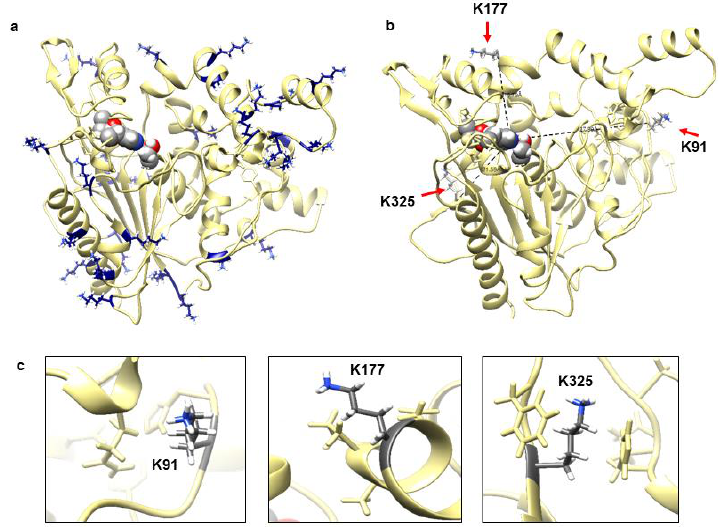
Figure 1. ( a ) Predicted model structure of WT lipase with catalytic triad in sphere shape located at the protein centre core. All lysine residues were distributed all over the protein surface were shown in heteroatoms colour. ( b ) The distance of three lysine residues (shown by red arrow) from catalytic triad (sphere shape heteroatom colour). ( c ) The location of three selected lysine (K91, K177, and K325) at coil, helix, and beta are shown in element colour with neighbouring residues. The figure was generated by Chimera v1.13.1.